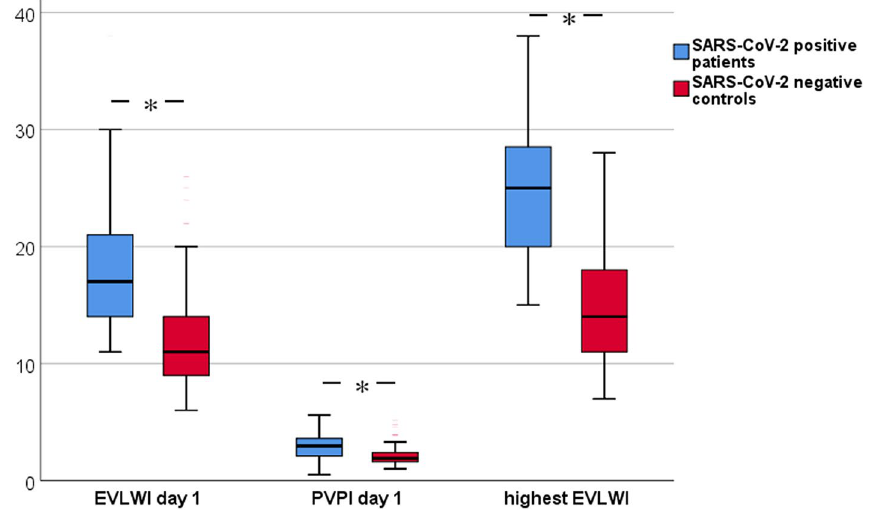
Figure 1. Boxplots comparing extra vascular lung water index (EVLWI) and pulmonary vascular permeability index (PVPI) on day 1 and highest EVLWI between patients with and without COVID-19; * indicates significance with p <